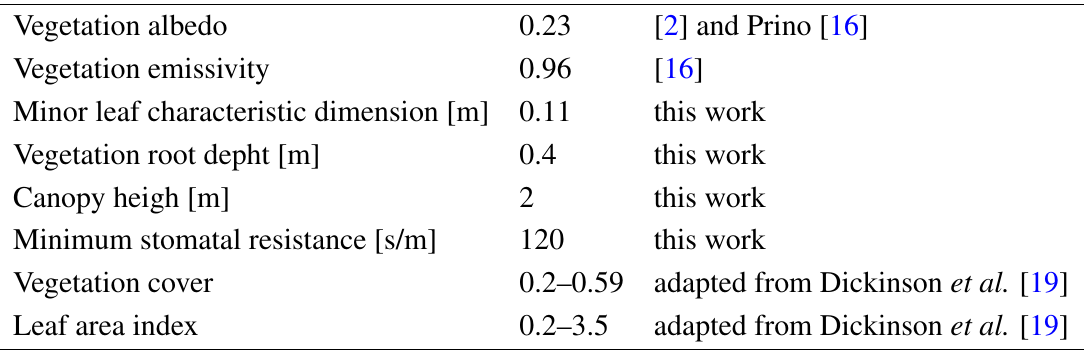
Table 1. List of vegetation parameters used to define the new class vineyard in the adapted Wilson and Henderson-Sellers